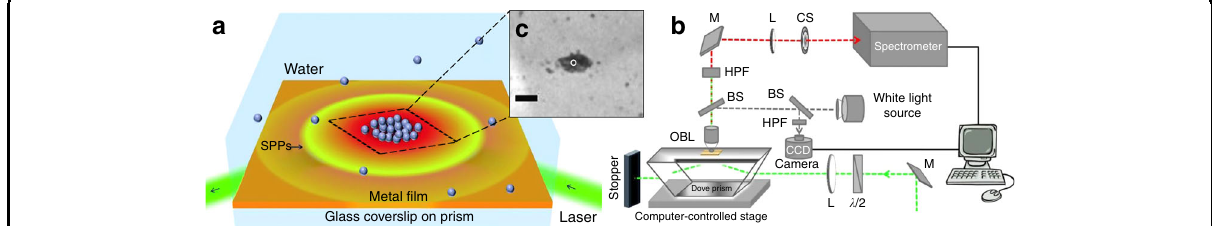
Fig. 8 Plasmonic trapping on a metal fi lm-coated prism substrate. a Schematic illustration of the simultaneous plasmonic assembly of nanoparticles, b optical setup of confocal Raman detection microscopy coupled with Dove-prism-based plasmon excitation, and c plasmon-assisted assembly of nanoparticles in the excitation region in experiments. a , c Reproduced with permission from ref. 146 , Copyright 2016 The Royal Society of Chemistry. b Reproduced with permission from ref. 147 , Copyright 2014 Nature Publishing Group